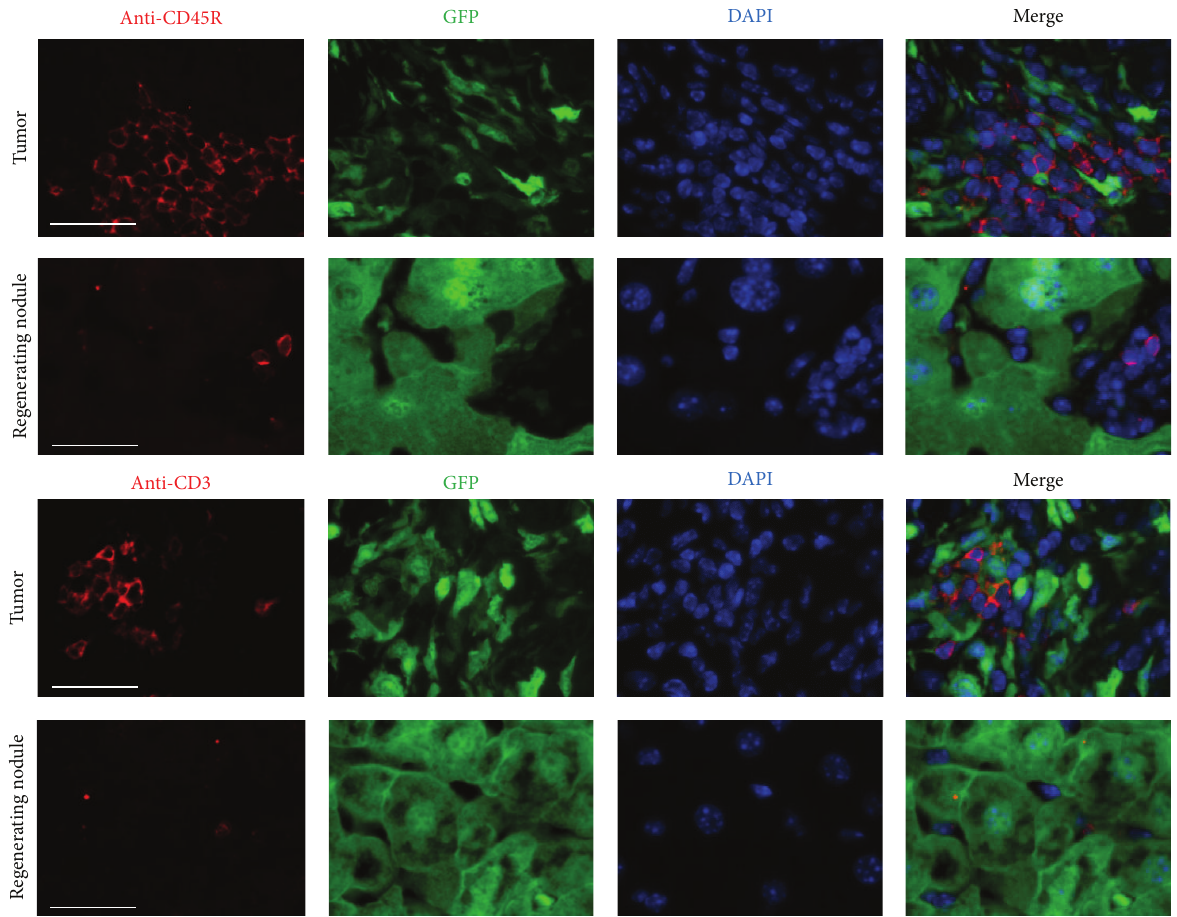
Figure 8: Comparison of B and T lymphocyte infiltration into regenerating nodules and liver tumors. Sections were stained with anti-CD45R and anti-CD3 antibodies (red). Immunofluorescence was used to detect donor BMC-derived GFP (green). Markedly increased numbers of B and T lymphocytes were observed in the tumor area compared to those in regenerating liver nodules. Scale bar represents 60 𝜇